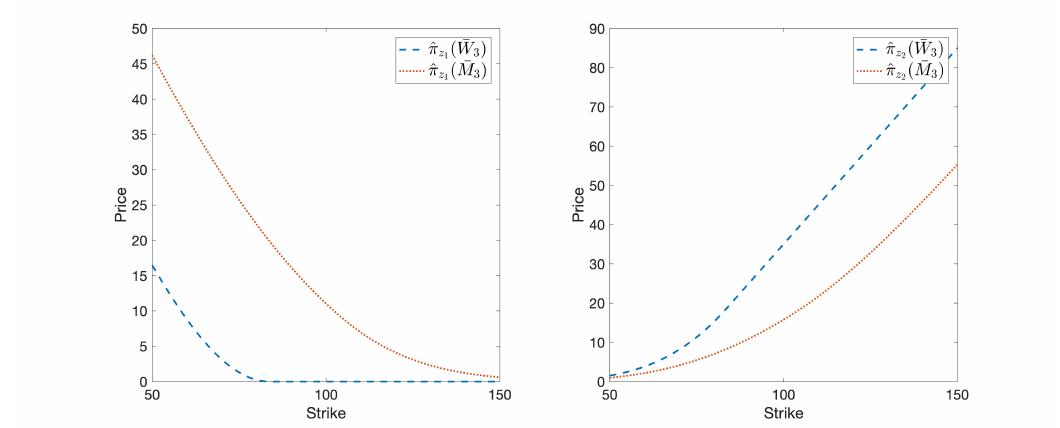
Figure 2: Bounds for Π ( Z 1 ) (left) and Π ( Z 2 ) (right) derived by the Fréchet–Hoeffding bounds as a function of the strike; Setting